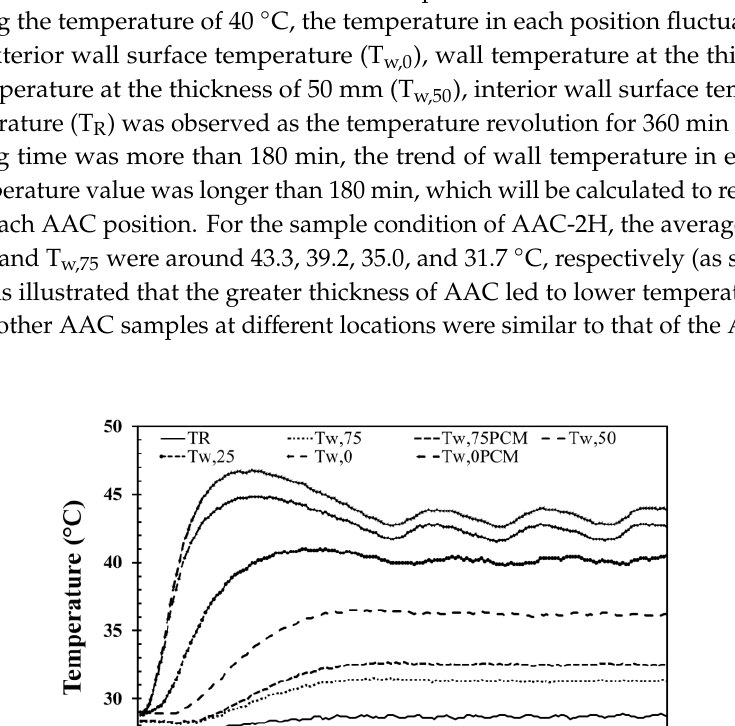
Figure 4. DSC plots showing the melting point of PCM.